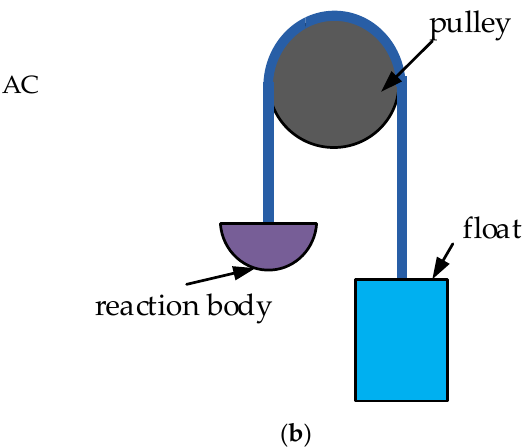
Figure 1. Float-type wave energy converter (WEC): ( a ) front view; ( b ) side view.